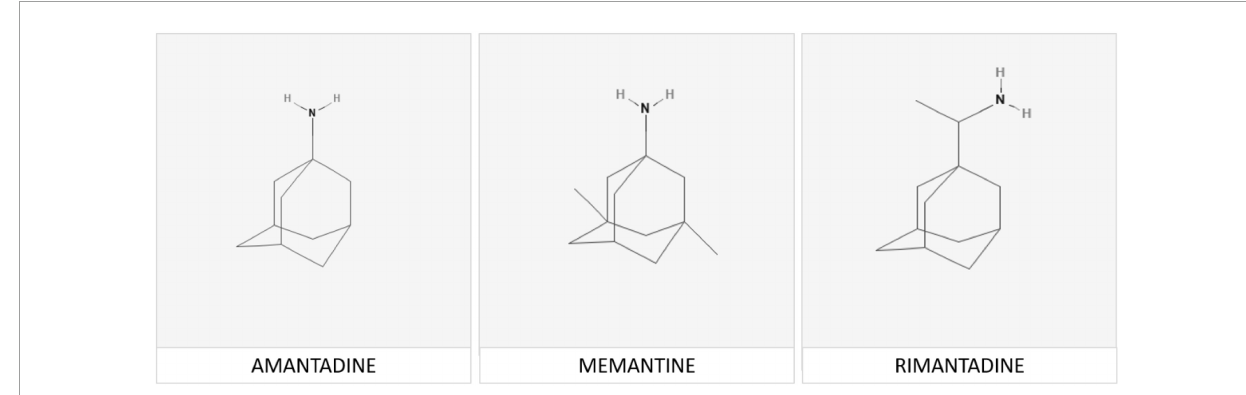
FIGURE1 Memantine [adamantan-1-amine] is a member of the adamantane family of agents. The adamantane molecule is composed of three condensed cyclohexane ring structures fused together in an armchair configuration with a functional group substituted at one of the four methyne positions that determines the specificity of each individual compound. Chemical structures of memantine and its analogs rimantadine and amantadine are shown above.